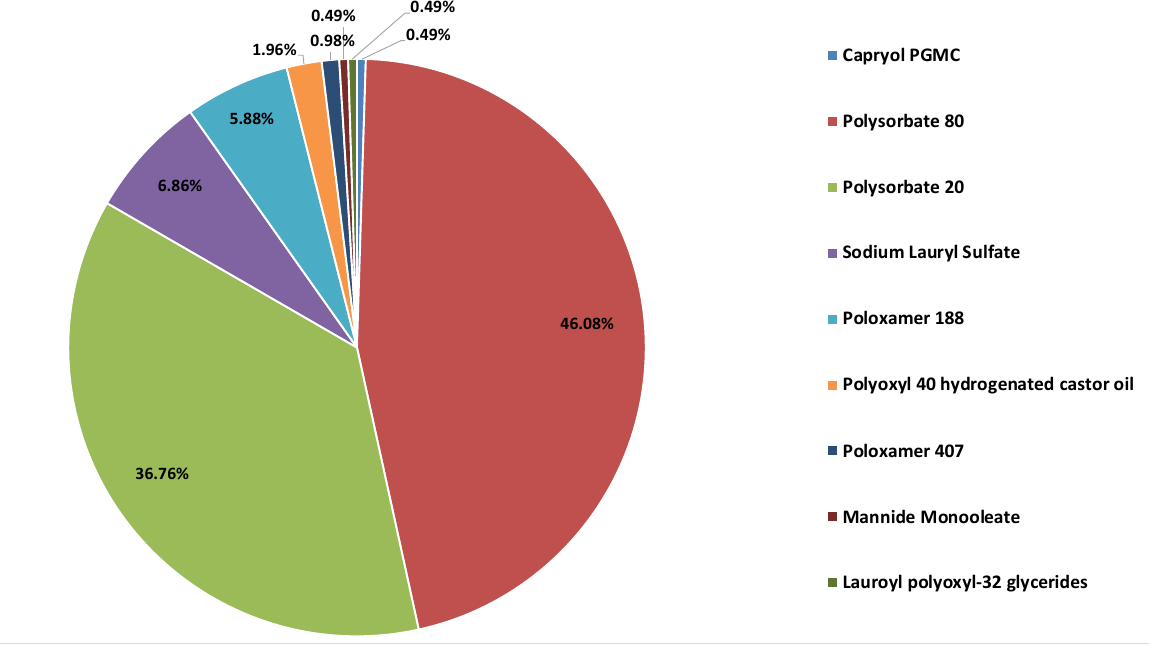
Figure 2. Percentage of instances for different surfactants found in the composition of the investigational medicinal products (IMPs).